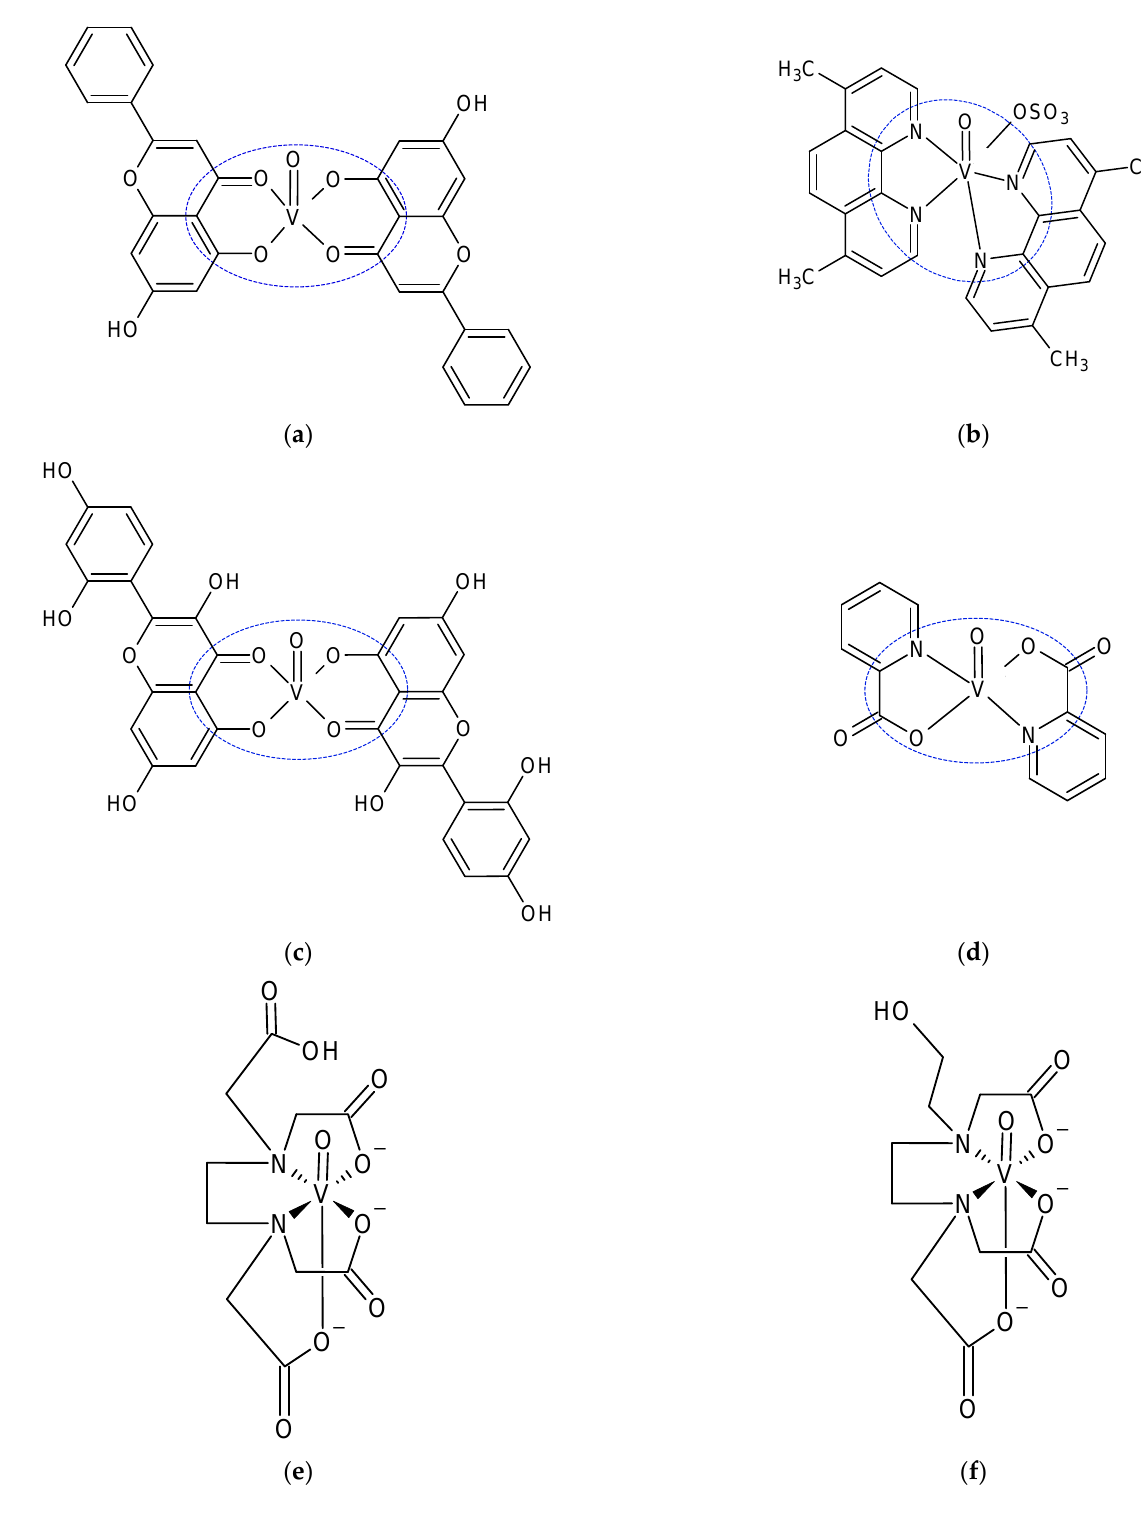
Figure 2. Examples of oxovanadium(IV) complex structures with antineoplastic activity ( a – c ) or insulin-enhancing properties ( d ). ( a ) chrysin oxovanadium(IV) complex at physiological pH; ( b ) bis(4,7-dimethyl-1,10-phenanthroline) sulfatooxovanadium(IV) complex (metvan); ( c ) morin oxovanadium(IV) complex; ( d ) picolinic acid oxovanadium(IV) complex. ( e ) V(IV)-EDTA complex; ( f ) V(IV)-HEDTA complex.